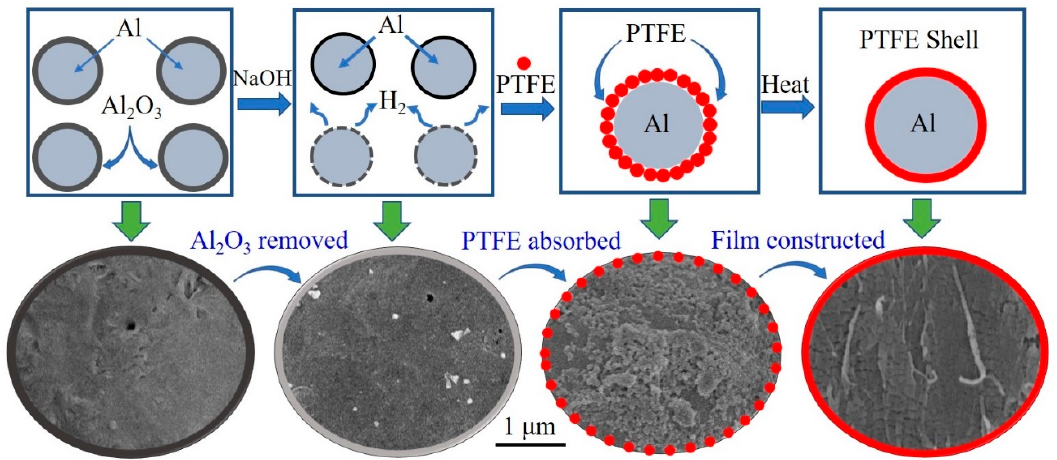
Figure 1. The diagram of the preparation process of aluminium/polytetrafluoroethylene (Al/PTFE) core-shell material. The red spots refer to PTFE particles. The bottom half of the diagram crop from scanning electron microscopy (SEM) images of prepared Al/PTFE.